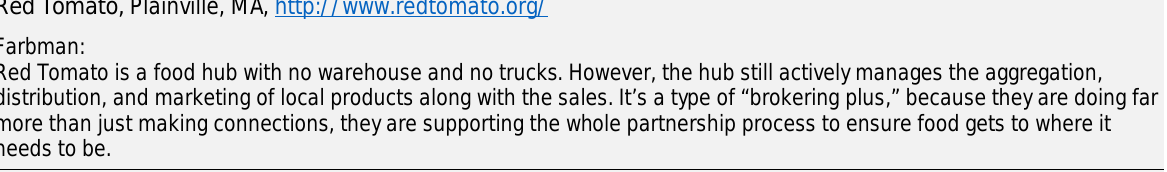
Figure 1. Some Examples of Innovative Food Hubs Described by Roundtable